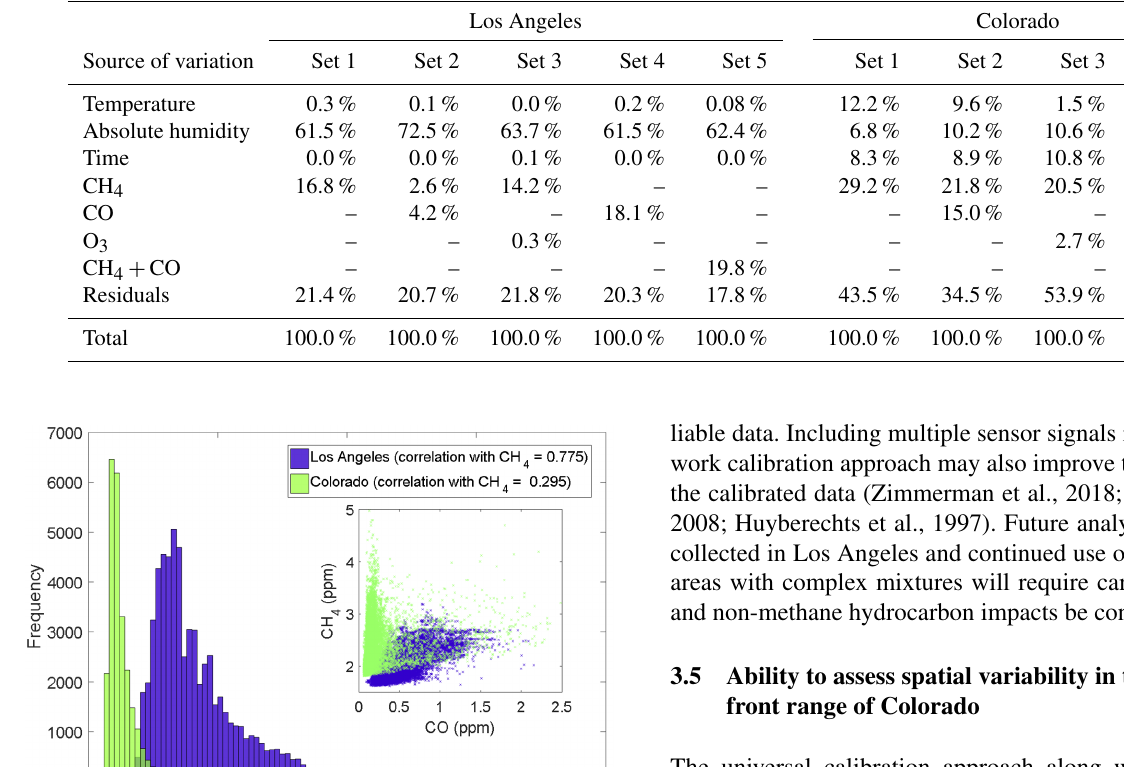
Table 6. Explained variance from ANOVA analyses on Figaro TGS 2600 resistance values ( R/R 0 ) for different parameter sets.